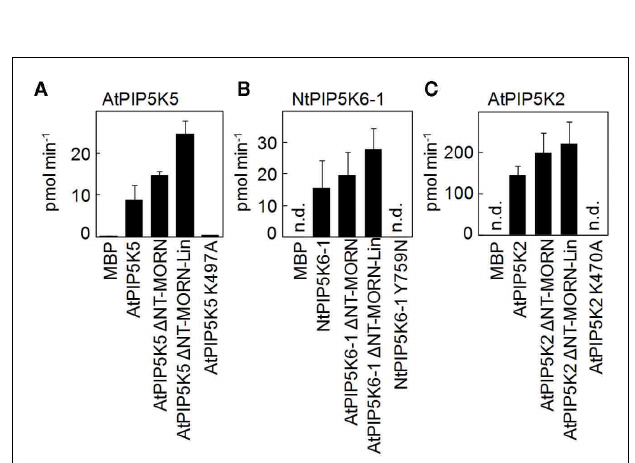
FIGURE 3 | Deletion of N-terminal domains does not impair in vitro catalytic activity of recombinant truncated variants ofAtPIP5K5, NtPIP5K6-1, orAtPIP5K2. PI4P 5-kinase variants used for localization experiments or to determine physiological effects on pollen tube growth were heterologously expressed in E. coli as fusions to N-terminal maltose-binding protein (MBP)-tags. AtPIP5K5, NtPIP5K6-1, AtPIP5K2,